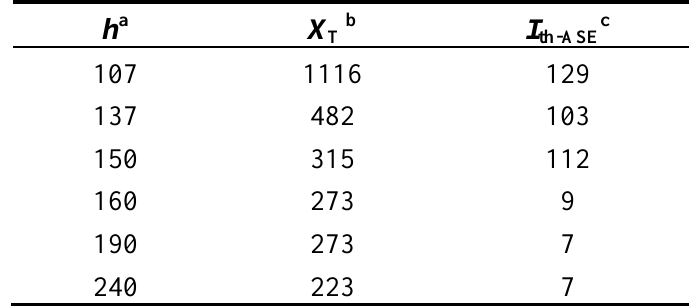
Table 1. ASE thresholds and penetration depth of the waveguide mode ( x doped PS films of various